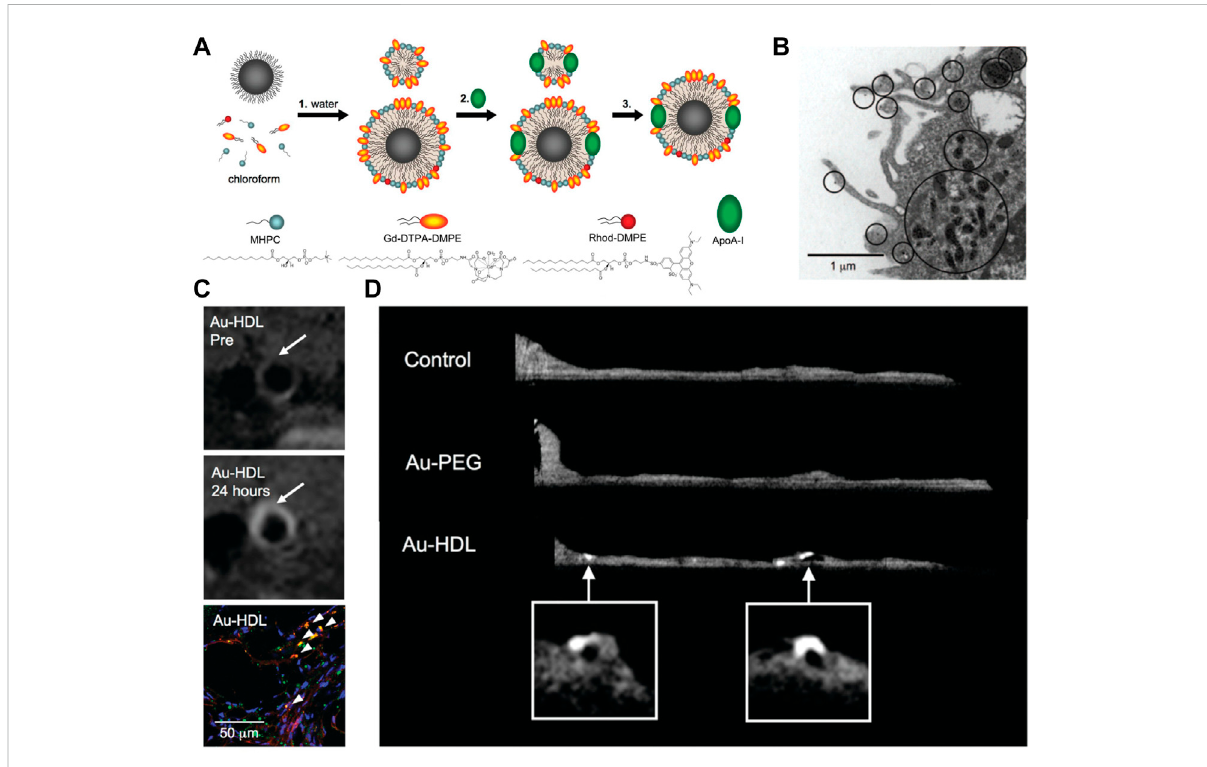
FIGURE 3 (A) Summaryofthesynthesisprocedureoftheagents. (B) TEMimageofparticleuptake. (C) T 1 -weightedMRimagesoftheaortaofApoE − / − mice pre- and 24 h post-injection with Au-HDL, and the corresponding confocal microscopy images. (D) Ex vivo sagittal CT images of the aortas of mice injected with Au-HDL, Au-PEG, and saline (Copyright permission from the American Chemical Society) (Cormode et al.,